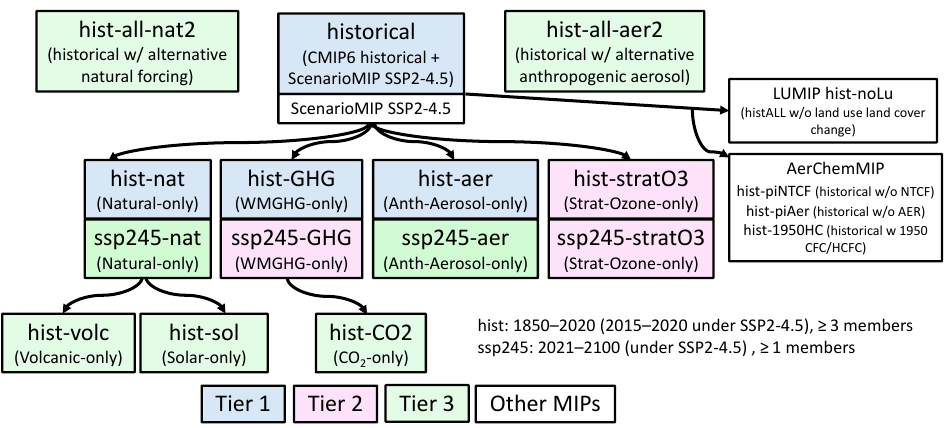
Figure 1. Schematic of the relationships of the various experiments proposed under DAMIP and other model intercomparison projects. Solid arrows indicate the decomposition into separated forced